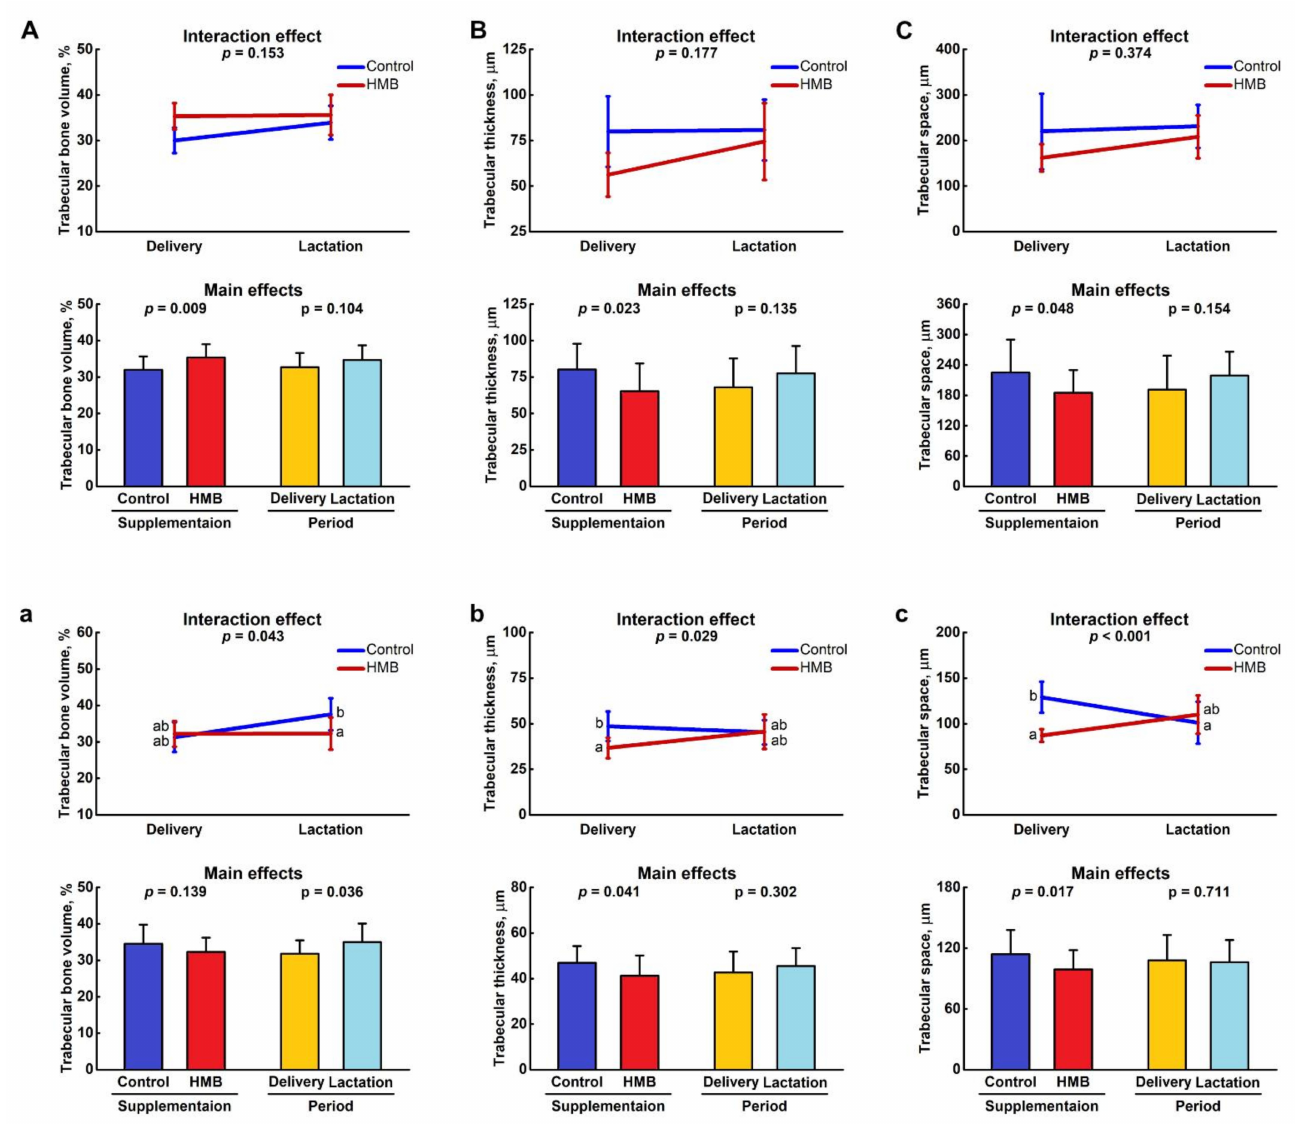
Figure 4. Effect of HMB supplementation (0.02 g/kg b.w.) during the middle trimester of pregnancy (13–26 d) on histomorphometry of femoral trabeculae in bone ( A – C ) metaphysis and ( a – c ) epiphysis of femora of spiny mice at delivery or after the lactation period. Figure shows LSMeans ± standard deviation as well as p -values of a two-way ANOVA with the supplementation (control, HMB) and period (delivery, lactation) and their interaction as fixed effects. Means with different letters in interaction effect plots differ significantly (Tukey’s post-hoc